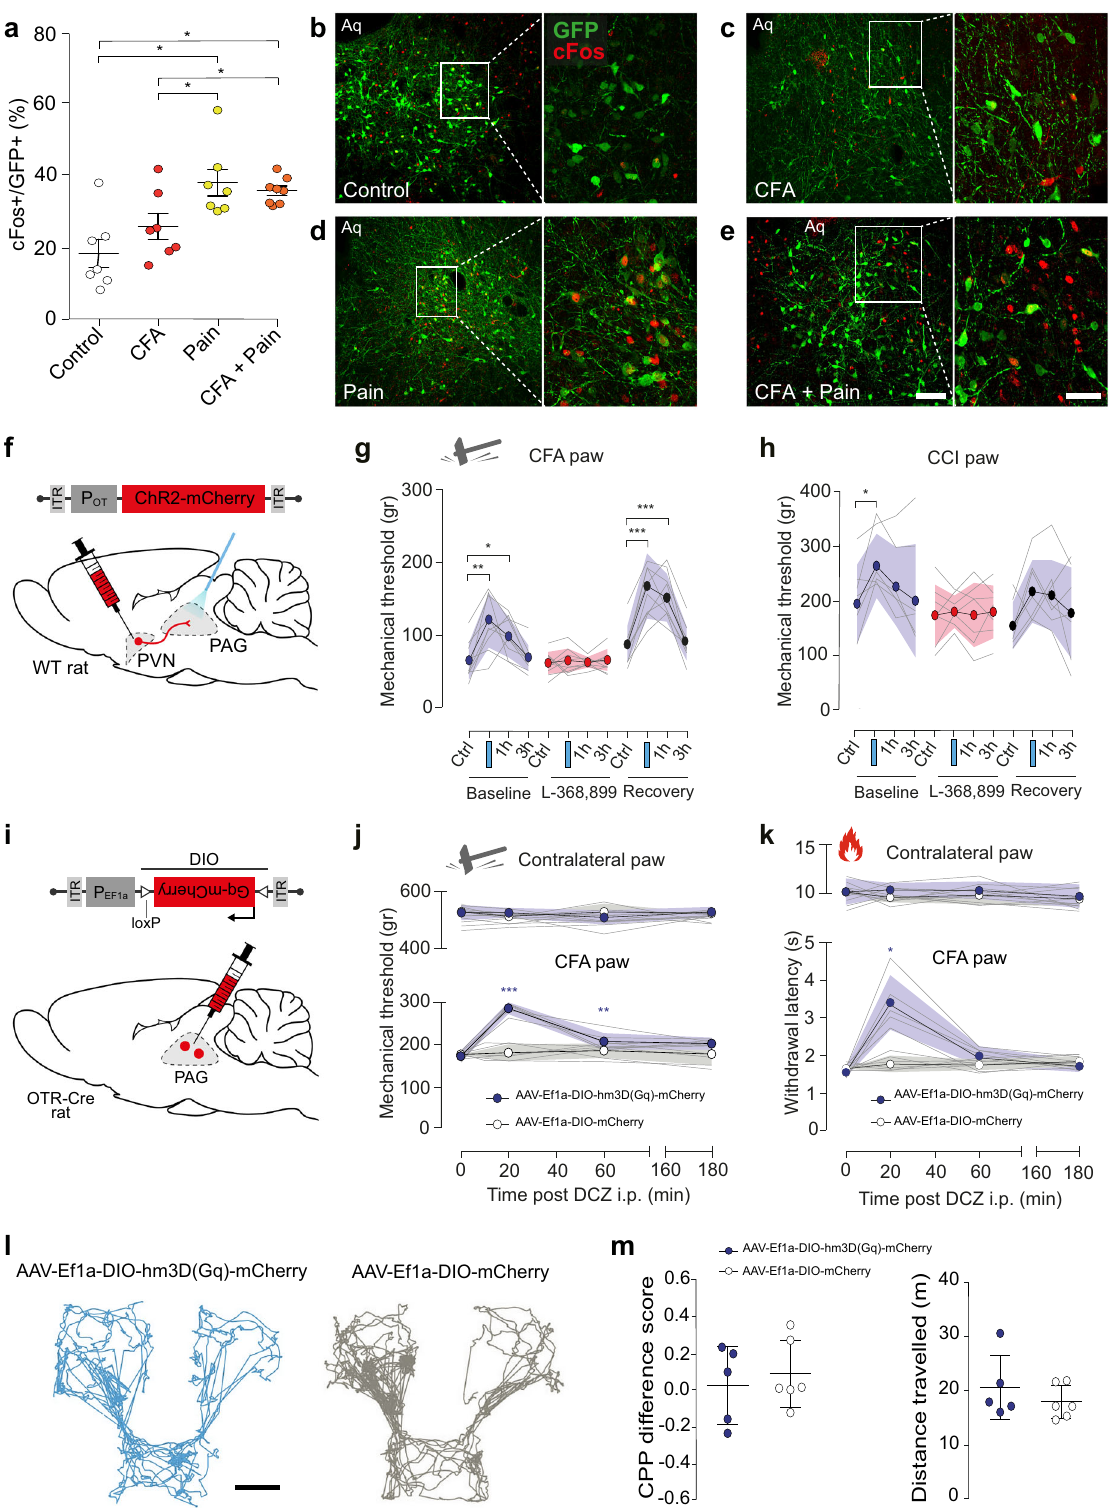
Fig. 10f, g, n = 6 per group), ruling out a potential sexual dimorphism of this